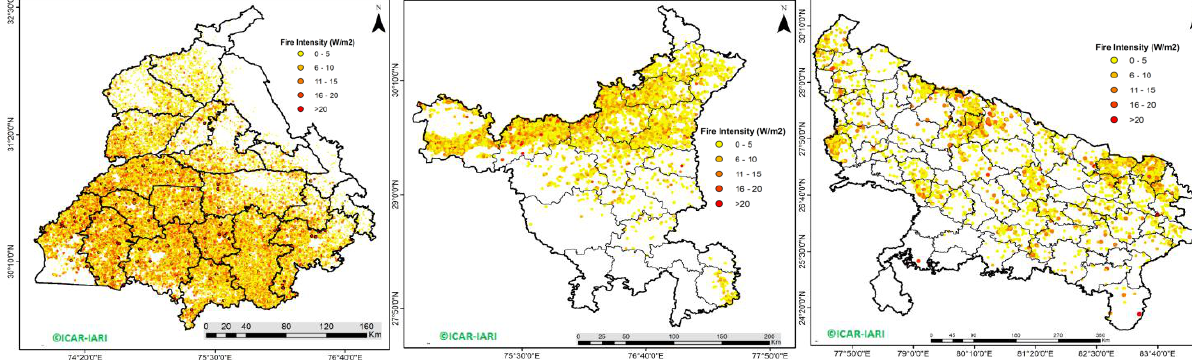
Figure 6. Spatial distribution of active fire locations (VIIRS, MODIS and AVHRR based) in (a) Punjab (b) Haryana and (c) Uttar Pradesh during 01 st October to 30 th November 2018.